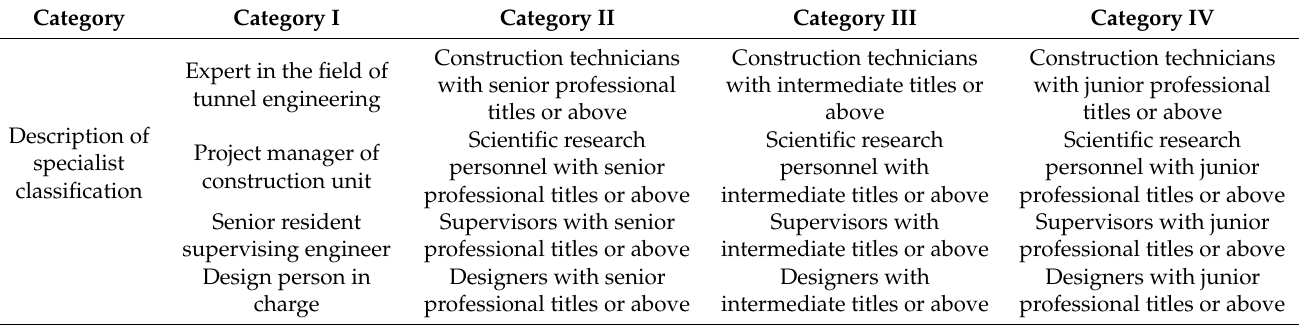
Table 2. Expert-classification table.